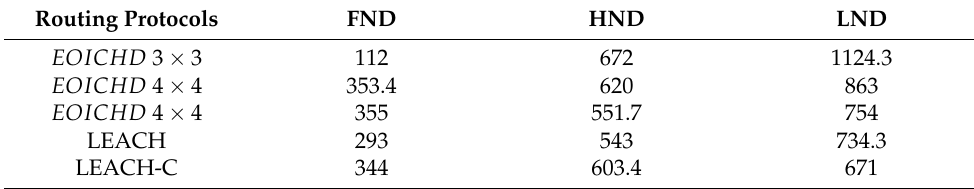
Table 4. FND HND LND,